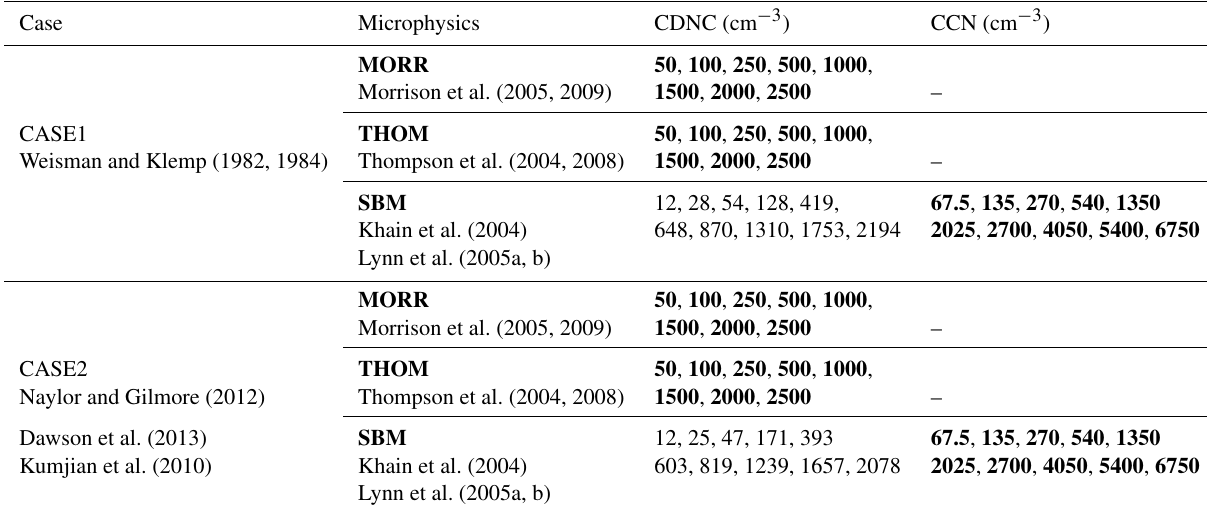
Table 1. Overview of the 52 simulations performed in this study, including the two cases simulated and the different CDNC/CCN values for each of the microphysics schemes. The CDNCs for the SBM simulations are the median values for grid points with a cloud water mixing ratio larger than 10gkg − 1 . Bold values of CDNC and CCN show parameters that were set in the simulation setup; the CDNC values for the SBM were diagnosed from the simulation